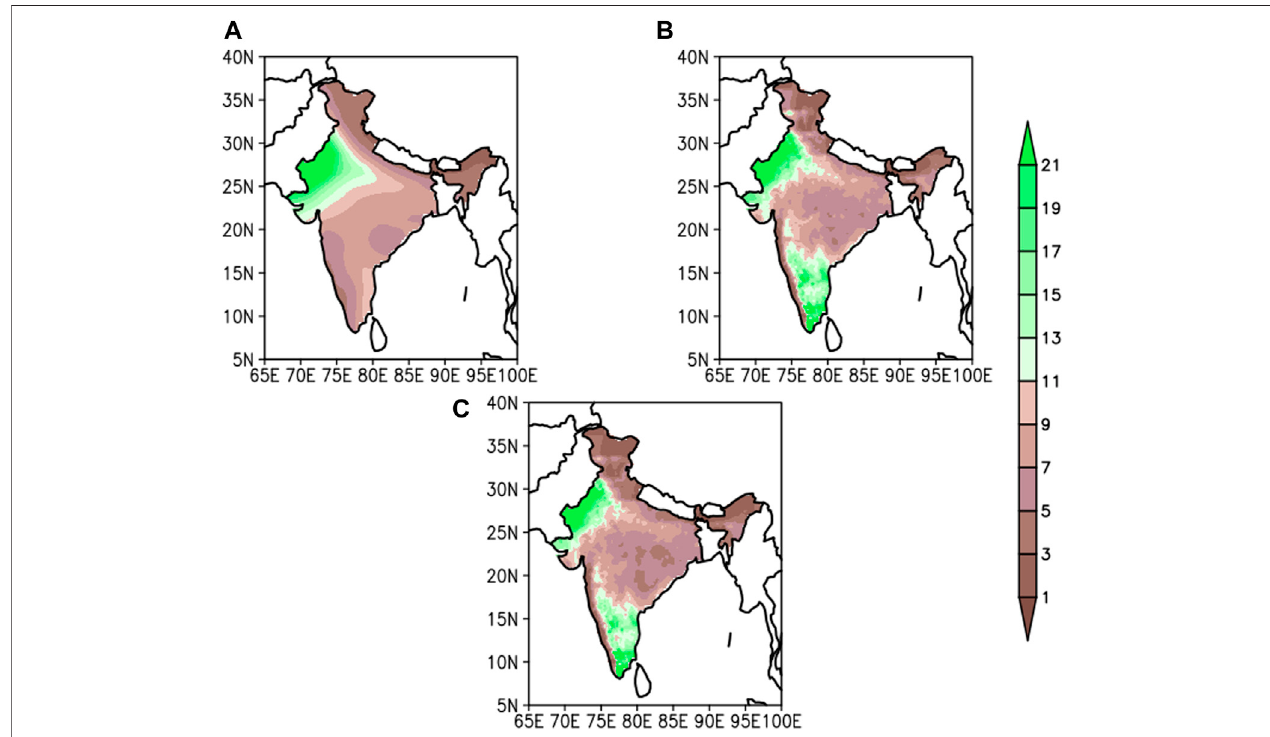
FIGURE 1 | Spatial pattern of mean monthly atmospheric residence times (ART) over India obtained from (A) CMIP5 MMM data sets, (B) water vapor of ERA and rainfall of IMD and (C) water vapor of NCEP and rainfall of IMD for the south west monsoon season of 1986 – 2005.